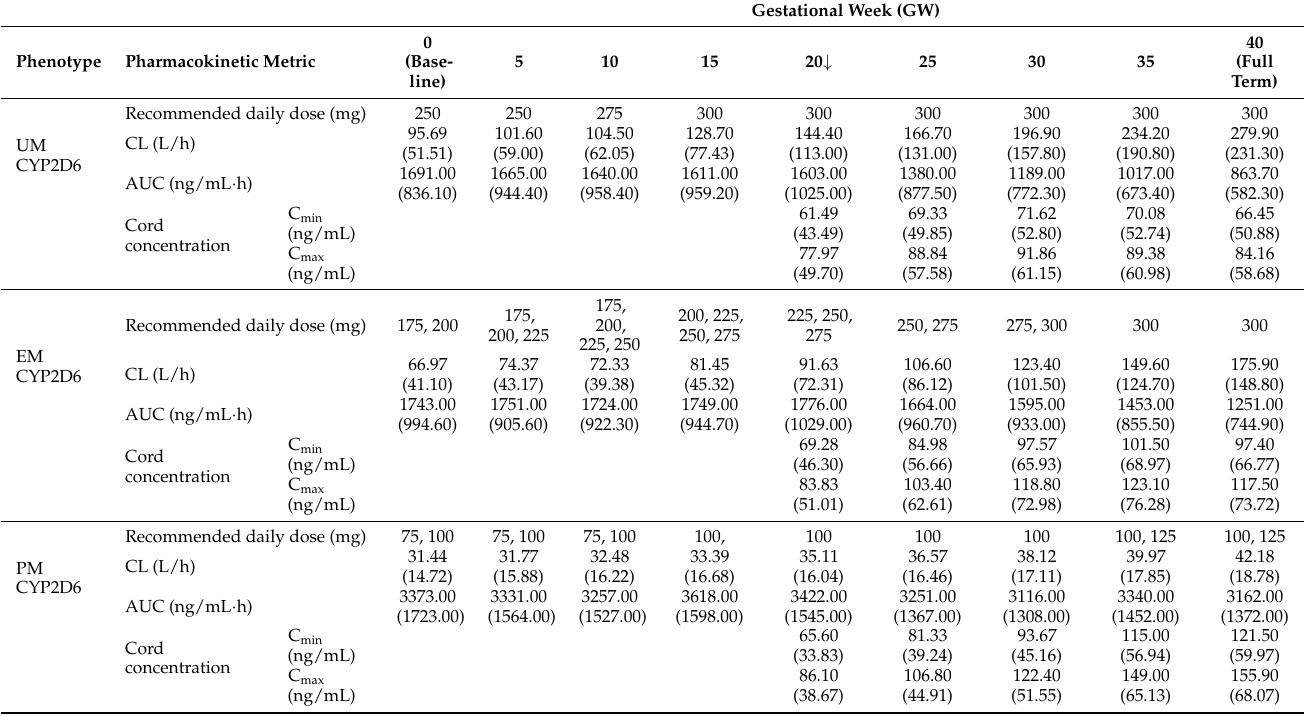
Table 8. Summary of recommended daily dose, predicted clearance, area-under-the-curve, and umbilical cord concentrations based on the recommended